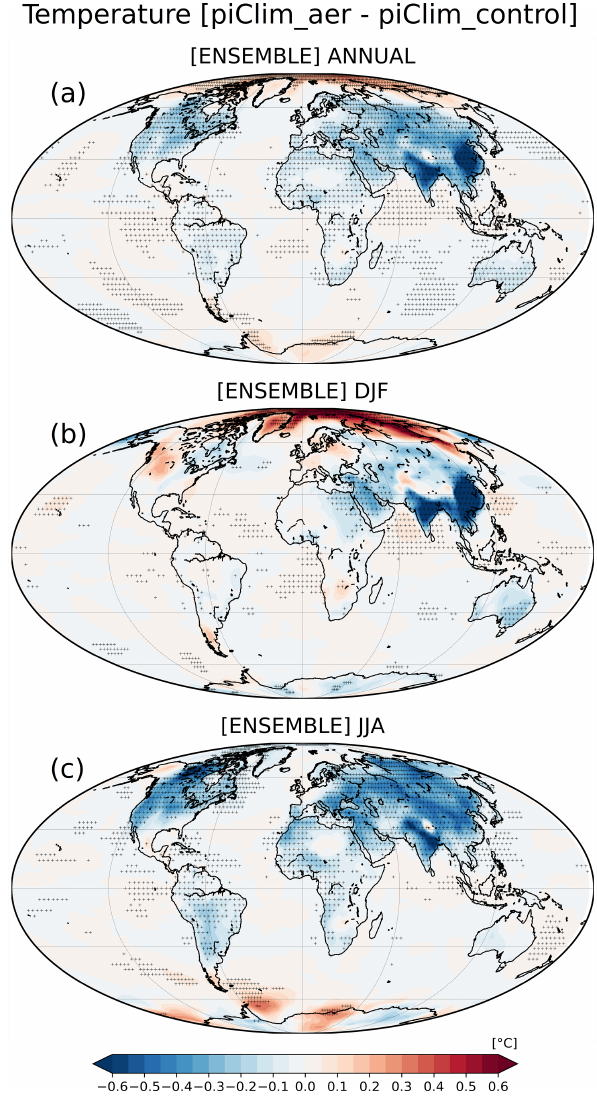
Figure 6. Differences between piClim-aer and piClim-control in near-surface temperature ( ◦ C) for the ensemble of 10 models (a) on an annual basis, (b) for DJF and (c) for JJA. The dot shading in- dicates areas in which the differences are statistically significant at the 95% confidence